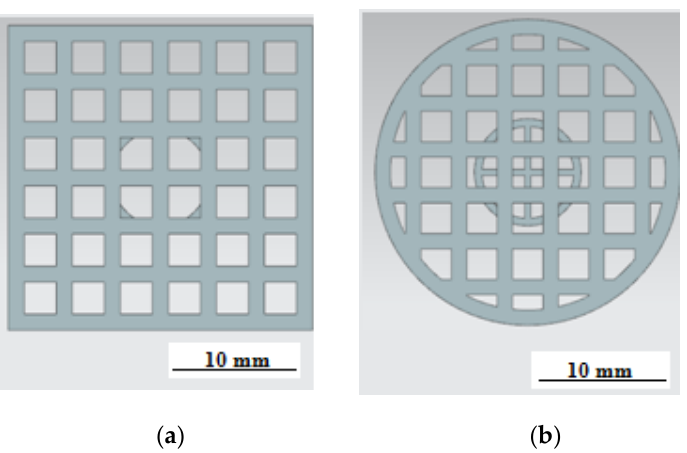
Figure 3. Three-dimensionalmodel of the electrode tool: ( a ) square ET and ( b ) round ET. A 7 × 10 mm cylinder was provided for fixing the electrode in the electrode holder (Figure 4).